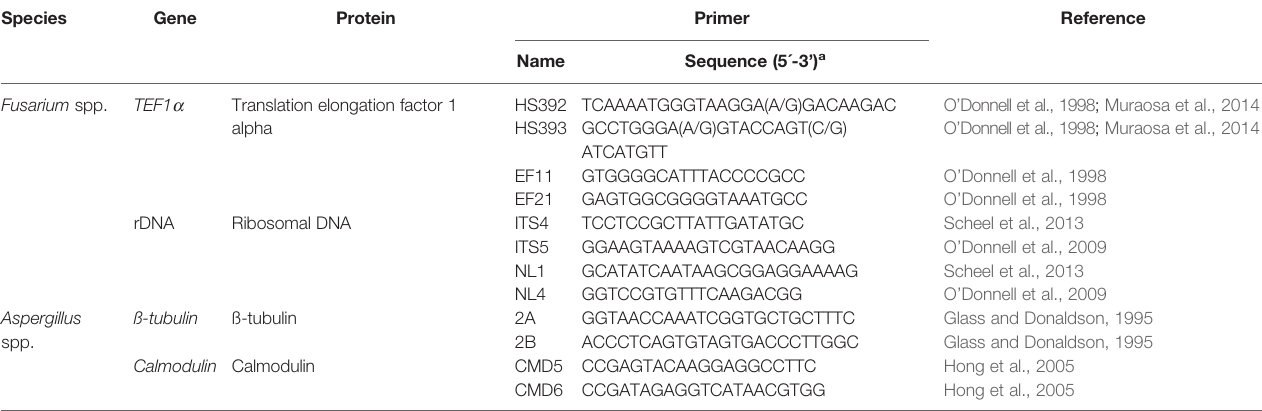
TABLE 1 | The sequence of primers used for sequencing environmental Fusarium and Aspergillus isolates. Species Gene